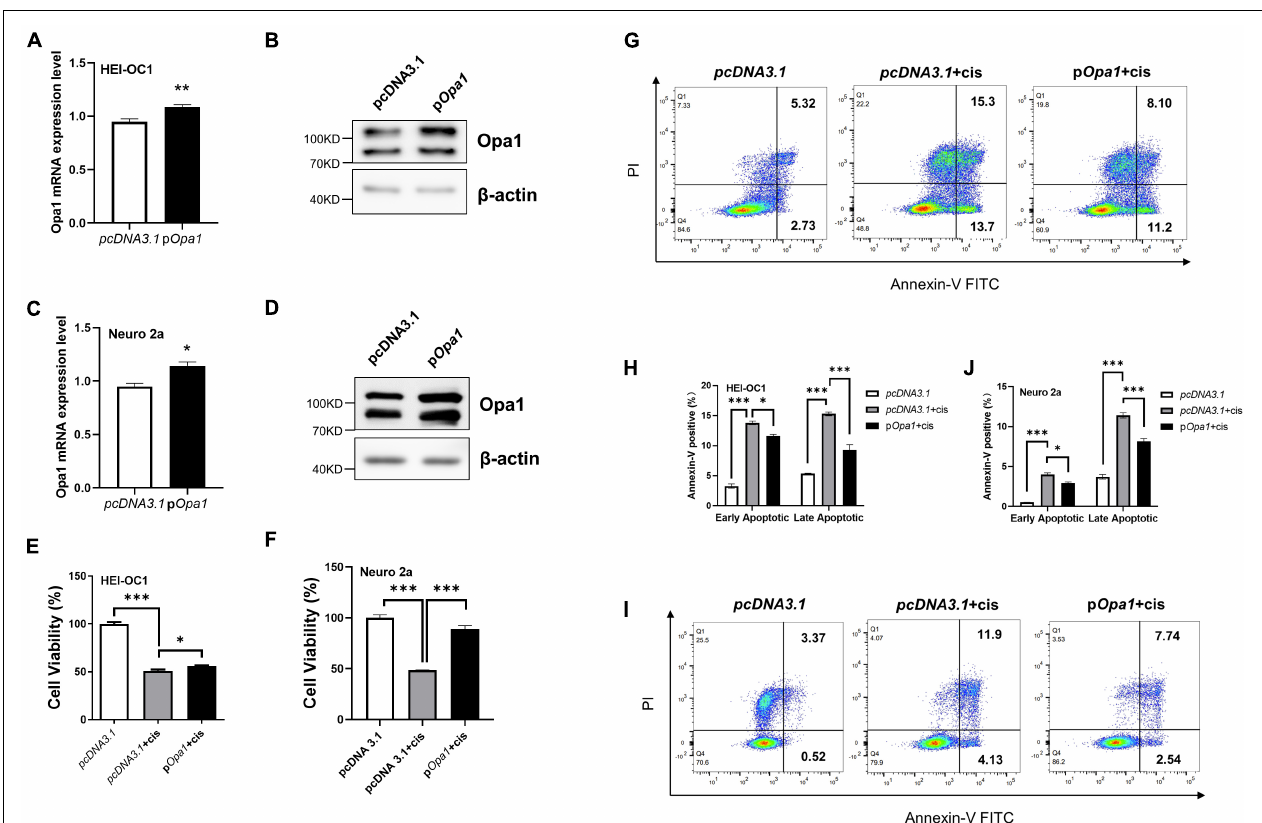
FIGURE 5 | Overexpression of Opa1 partially restores cisplatin-induced apoptosis in HEI-OC1 and Neuro 2a cells (A) Quantification of Opa1 mRNA expression in HEI-OC1 cells transfected with Opa1 for 24 h. ** p < 0.01 (non-parametric Mann-Whitney t -test). (B) Representative Western blot images showing the Opa1 protein expression level in HEI-OC1 cells transfected with Opa1 for 48 h. (C) Quantification of Opa1 mRNA expression in Neuro 2a cells transfected with Opa1 for 24 h. * p < 0.05 (non-parametric Mann-Whitney t -test). (D) Representative Western blot images showing the Opa1 protein expression level in Neuro 2a cells transfected with Opa1 for 48 h. (E,F) CCK-8 was used to assess cell viability in HEI-OC1 (E) and Neuro 2a (F) cells at 24 h after cisplatin treatment with or without Opa1 transfection. * p < 0.05, *** p < 0.001 (one-way ANOVA with Dunnett’s multiple comparisons test). (G) Representative flow cytometric plots were generated from HEI-OC1 cells stained with Annexin V-FITC/PI to detect apoptosis at 24 h after cisplatin treatment with or without Opa1 transfection. (H) The percentages of early and late apoptotic cells in each group. * p < 0.05, *** p < 0.001 (two-way ANOVA). (I) Representative flow cytometric plots were generated from Neuro 2a